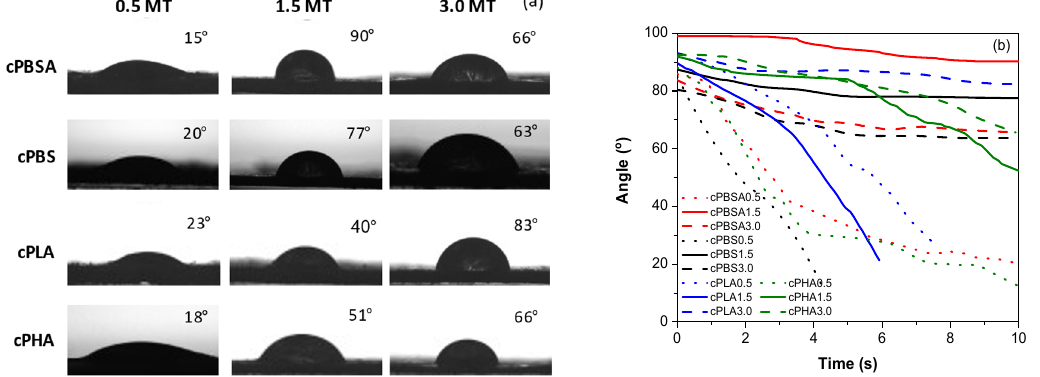
Figure 4. ( a ) Pictures of contact angles for laminates measured on the paper side and ( b ) contact angle vs. time for laminates measured on the paper side.